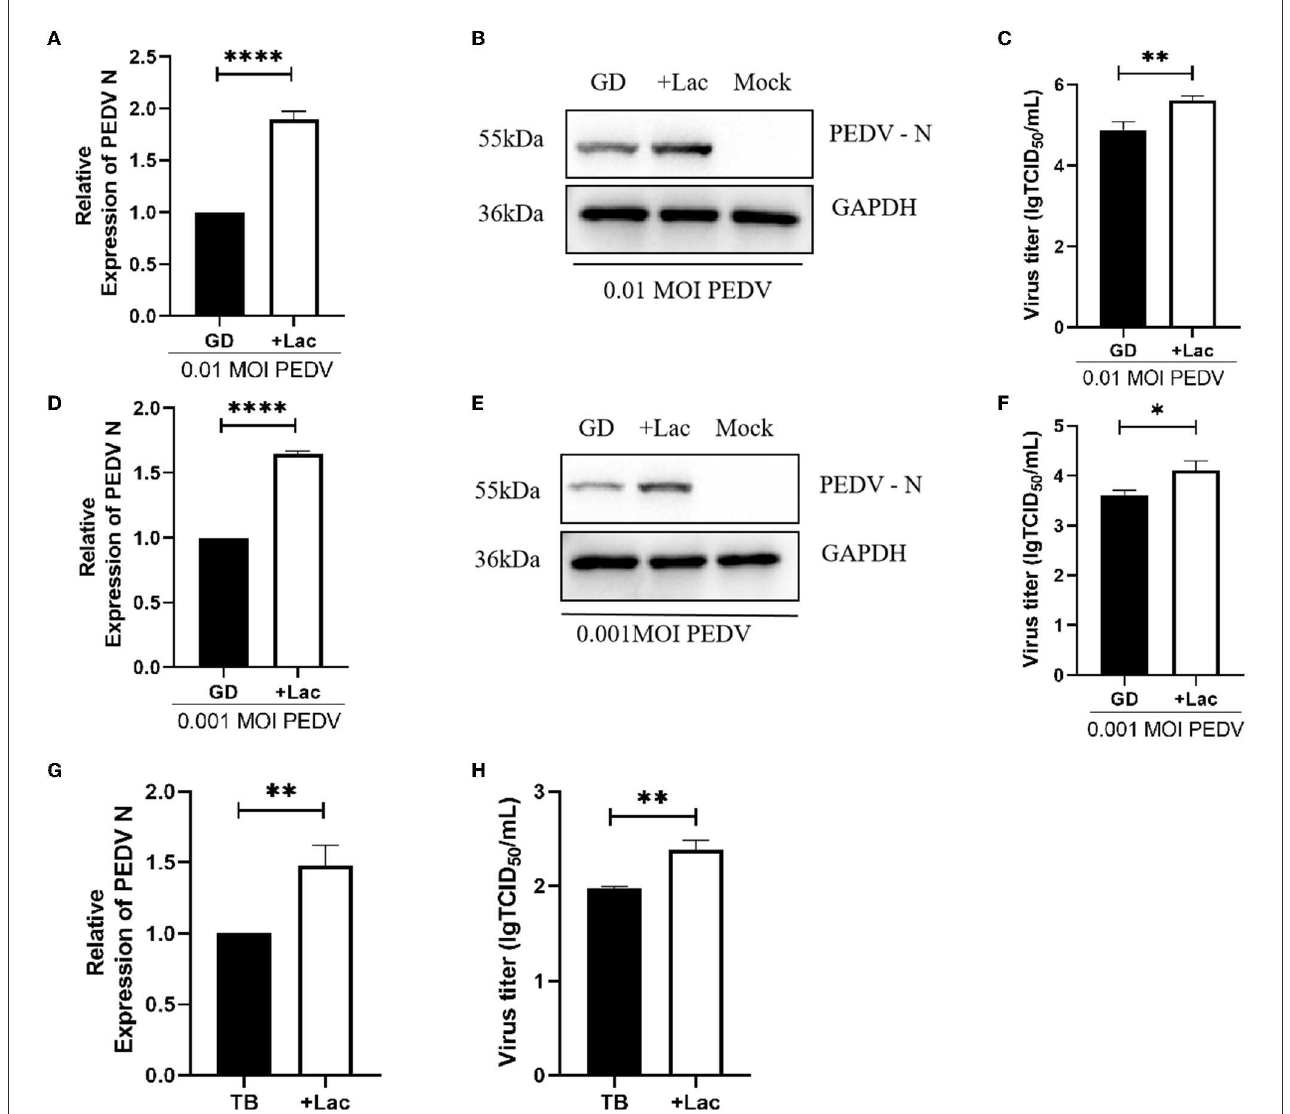
FIGURE4 Lactate promotes the replication of PEDV variant strains in Vero cells. (A–C) Enhanced viral replication of 0.01 MOI PEDV GD/HZ/2016 strain in Vero cells after addition of 10mM lactate to normal DMEM, as shown by the analysis of the PEDV N mRNA levels (A) , protein levels (B), and viral titer (C) . (D–F) Ten millmolar lactate has a viral replication-promoting effect on the PEDV GD/HZ/2016 strain at 0.001 MOI. PEDV N mRNA levels (G) and viral titers (H) indicated that 10mM lactate has a promoting effect on laboratory-preserved variant PEDV TB strains. * p < 0.05; ** p < 0.01; **** p <